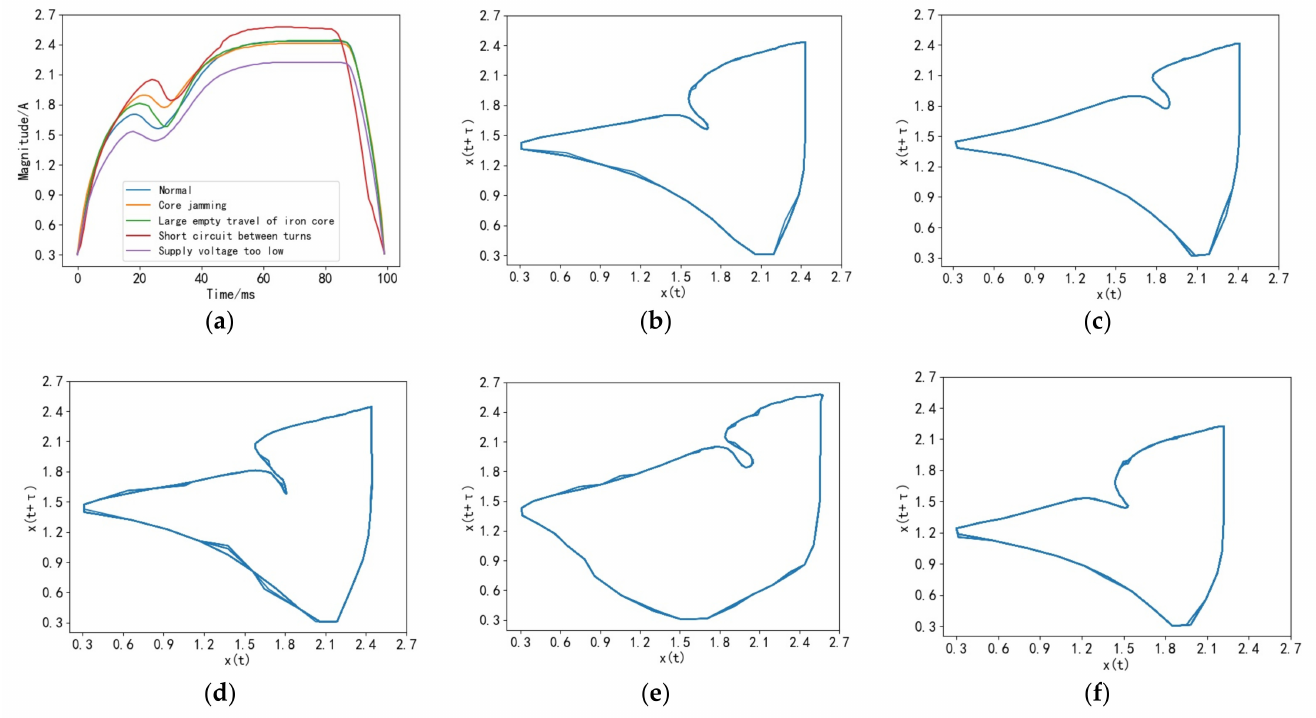
Figure 10. Current signals in different states and corresponding multi-period phase planes: ( a ) com- parison of time-domain waveforms of current signals under different states; ( b ) normal state phase trajectory; ( c ) core card astringent phase track; ( d ) core empty travel large phase trajectory; ( e ) inter- turn short-circuit phase trajectory; ( f ) supply voltage too low phase